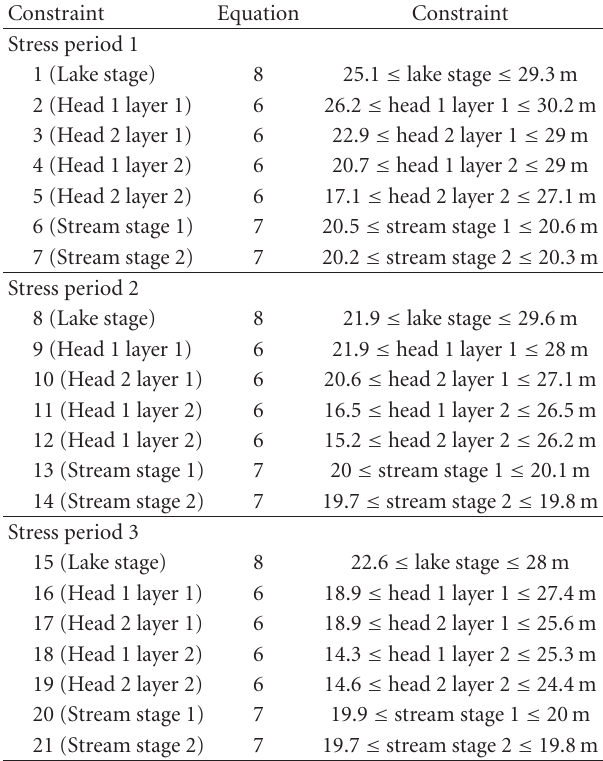
Table 5: Bounds on state